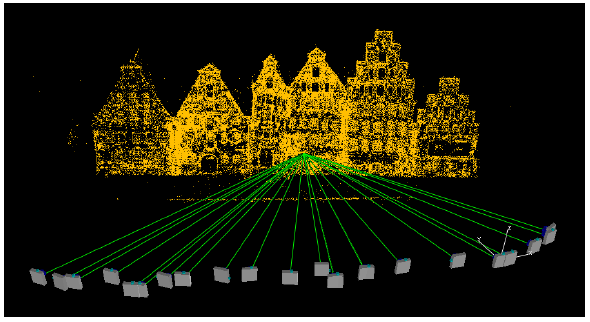
Figure 2. Configuration for the 80000-point, 23-image Salzspeicher network.